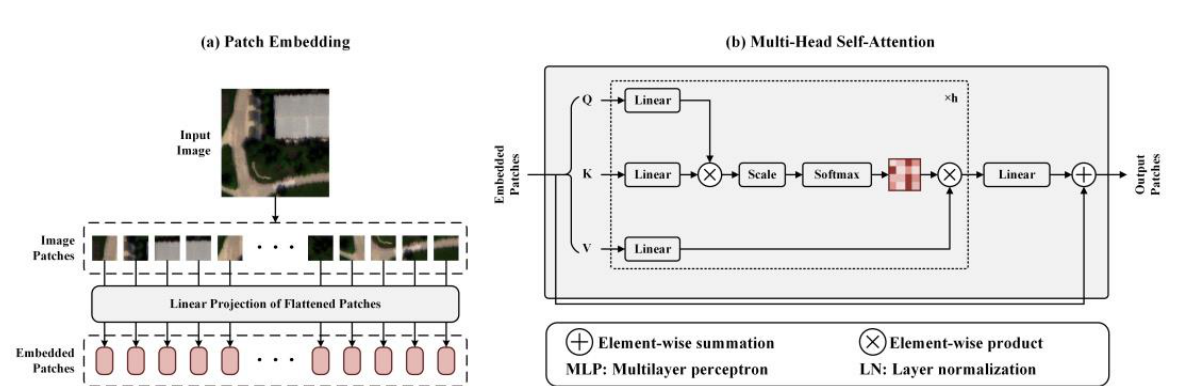
Figure 6. Patch embedding and multi-head self-attention mechanism.